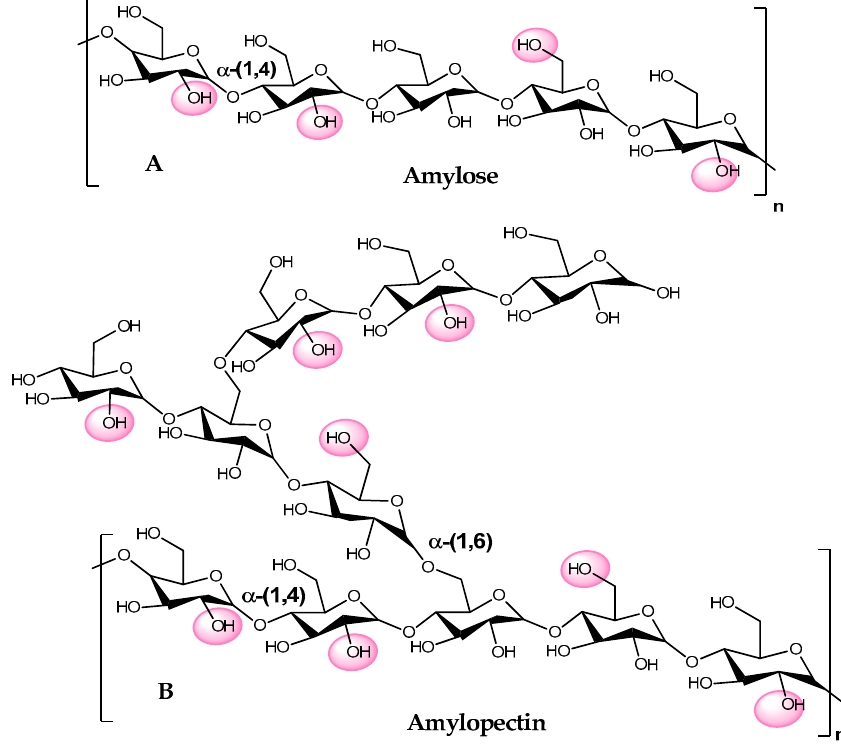
Figure 14. Schematic representation of the structure of starch. Two different polysaccharides are present in starch: ( A ) linear (1,4)-linked α - D -glucose (amylose) and ( B ) highly branched α - D -glucose (amylopectin). The light pink circles randomly highlight the hydroxyl groups that can be chemically modified.